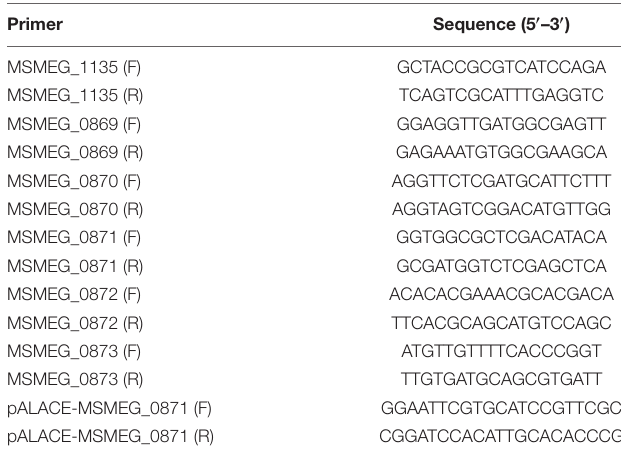
TABLE 1 | Primers used in the